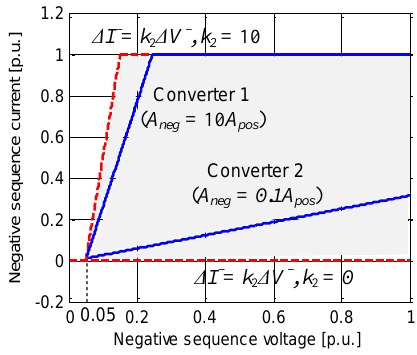
Figure 19. Two SPC-based power converters working with different negative sequence virtual admittances. The V − -I − slope of the two converters compared with the VDE grid codes.